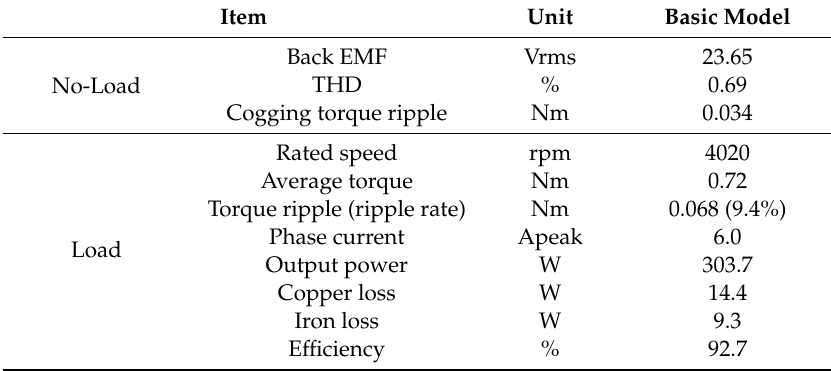
Table 2. Characteristics of the basic spoke type ferrite IPM